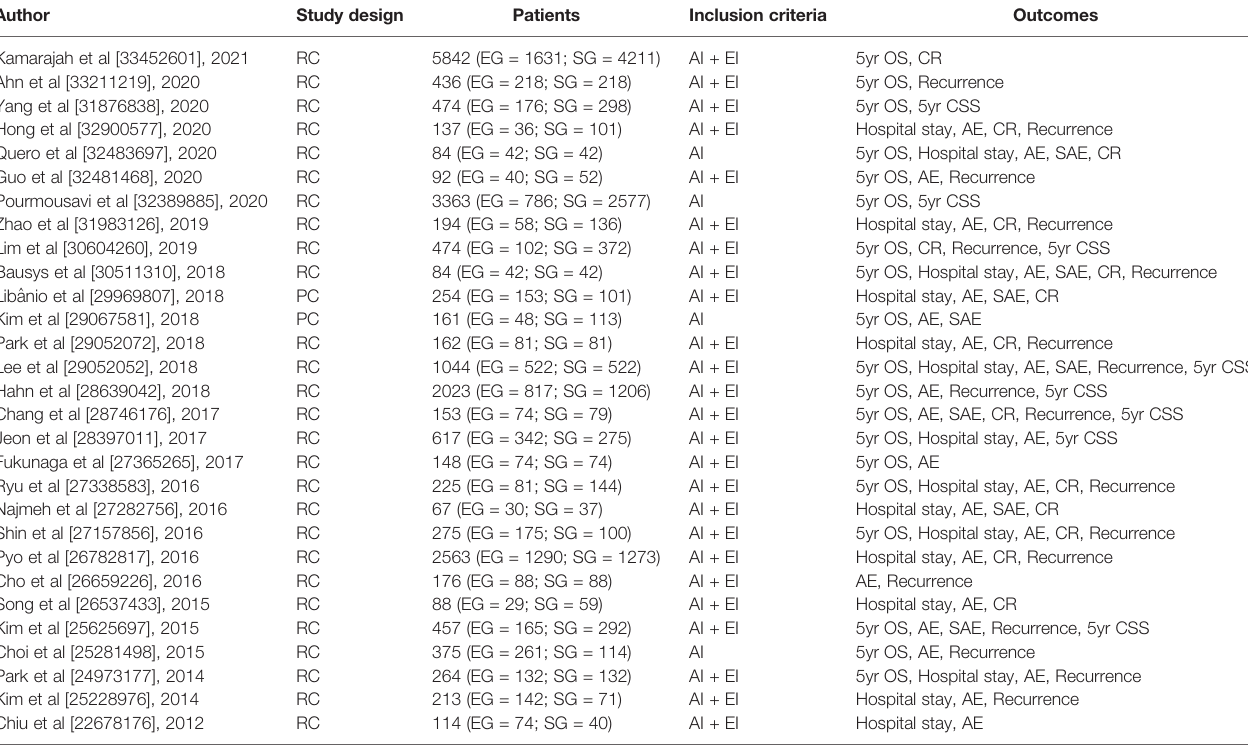
TABLE 1 | Characteristics of the